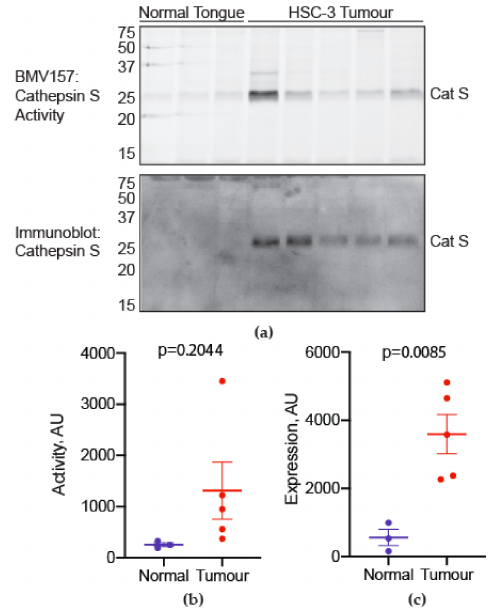
Figure 5. Cathepsin S activity is increased in the oral cancer of the mouse orthotopic xenograft model compared to mouse normal tongue. ( a ) Active cathepsin S labeled by BMV157 (upper panel) as shown by in-gel fluorescence and total cathepsin S immunoreactivity (lower panel). The gel (upper panel) was transferred to nitrocellulose and immunoblotted for total cathepsin S levels (lower panel). The uncropped western blot figure is presented in Figure S2. ( b ) Cathepsin S activity was higher in oral HSC-3 xenografts compared to normal tongues (unpaired Student’s t -test). ( c ) Cathepsin S expression was higher in HSC-3 xenografts compared to normal tongues (unpaired Student’s t